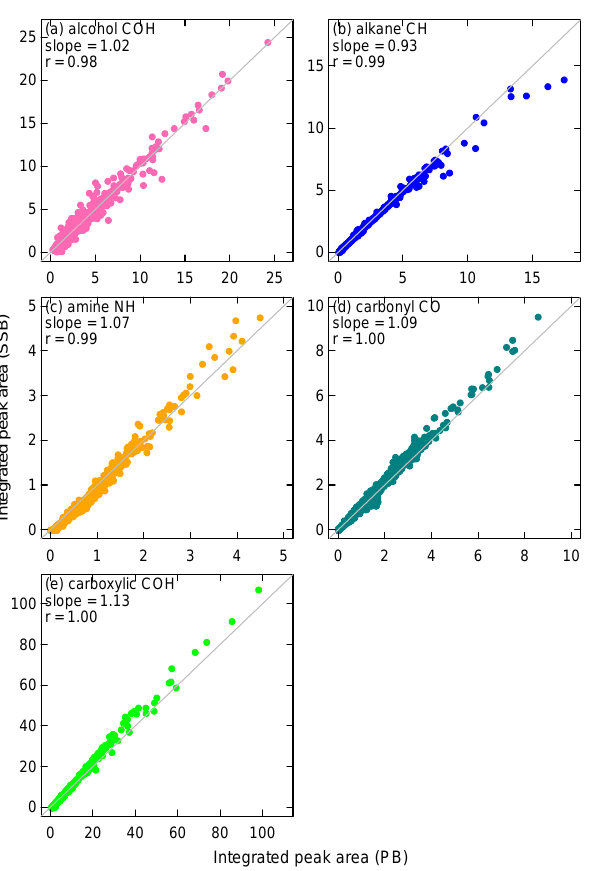
Figure 8. Integrated peak area corresponding to different func- tional groups (a–e) from polynomial baseline and smoothing splines baseline-corrected spectra. Slope magnitudes represent the slope of the regressed line. The silver line represents a one to one line.